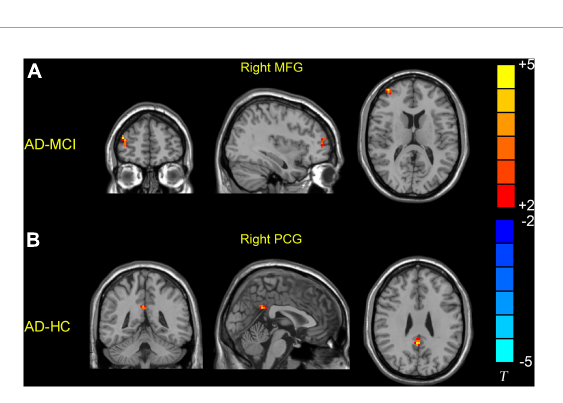
FIGURE2 Brain regions showing increased dReHo values in the AD group relative to the MCI and HC groups. (A) Patients with AD showed higher dReHo values in the right MFG than patients with MCI. (B) Patients with AD showed higher dReHo values in the right PCG than the HC group. HC, healthy control; MCI, mild cognitive impairment; AD, Alzheimer’s disease; MFG, middle frontal gyrus; PCG, posterior cingulate